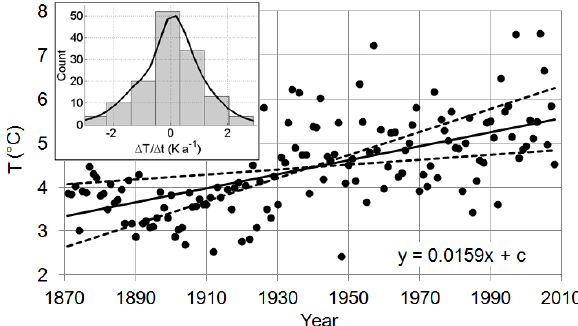
Fig. 6. Mean melt season (1 April to 30 September) 900mb air tem- perature ( T ) over the 1871 to 2008 period at Columbia Glacier ex- tracted from the Twentieth Century Reanalysis V2 data provided by NOAA/OAR/ESRL PSD (Compo et al., 2011). Inset: Correspond- ing histogram and non-parametric distribution of annual variability in 900mb air temperature ( 1T / 1t)